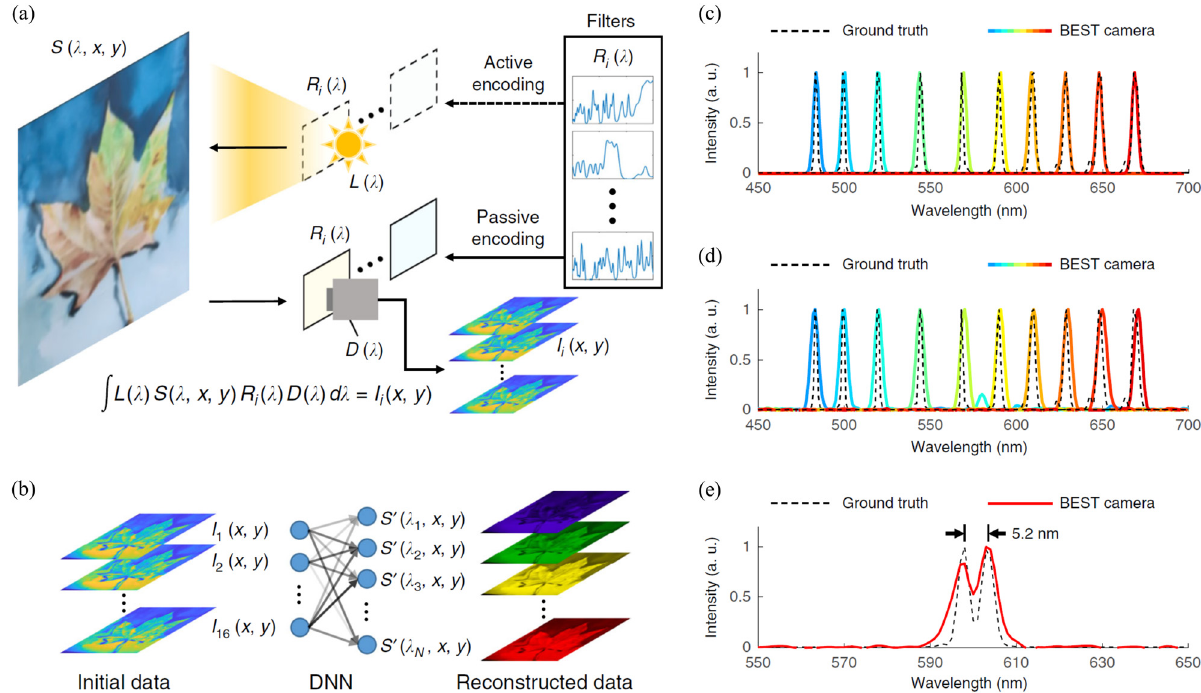
Figure 9: Principle and performance of broadband encoding stochastic camera. (a) Simplified schematic. Depending on where the light spectrum is encoded, the camera can work either in the active (upper) or passive (lower) modes. (b) Principle of DNN-based spectral reconstruction algorithm. The initial data captured by the monochrome camera is fed into the DNN and outputs the reconstructed 3D hyperspectraldatacube.(c)and(d)Spectralpro fi lesoflaserbeamswithnarrowbandwidth.In(c),theDNNistrainedbythe “ precise ” dataset, whereas (d) is for the results from the DNN trained by “ general ” datasets. (e) Spectral pro fi le of two peaks corresponding to 598.0 and 603.2nm.Thepeak-to-peakdistanceishighlightedinblack.In(c – e),thegroundtruthsandtheDNN-reconstructedresultsarerepresentedby dashed (ground truth) and solid (reconstructed) curves, respectively. The graphs are normalized to their peak intensity. (a – e) are reprinted with permission from Ref. [39], copyright 2021 Nature Publishing